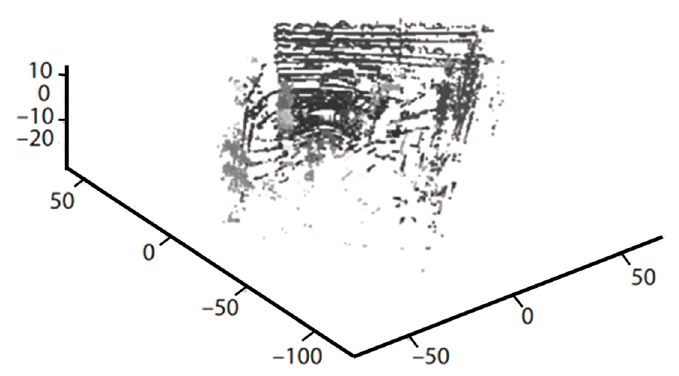
Figure 10. Reconstructed 2D Image from PC data.